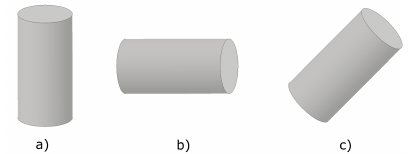
Figure 1. Orientation of the specimens durig produc- tion: a) vertical, b) horizontal and c) tilted.